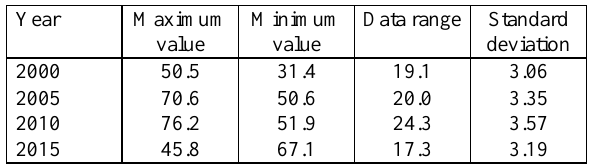
Table 2. Statistics of PM2.5 concentration in Wuhan from 2000 to 2015